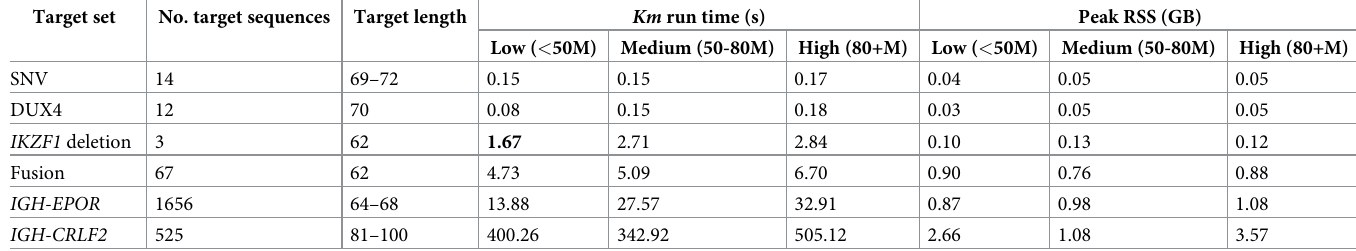
Table 1. Memory and runtime requirements for variant detection from previously indexed RNA-seq data. Values represent mean time and memory for samples of specified sequencing depth. Target